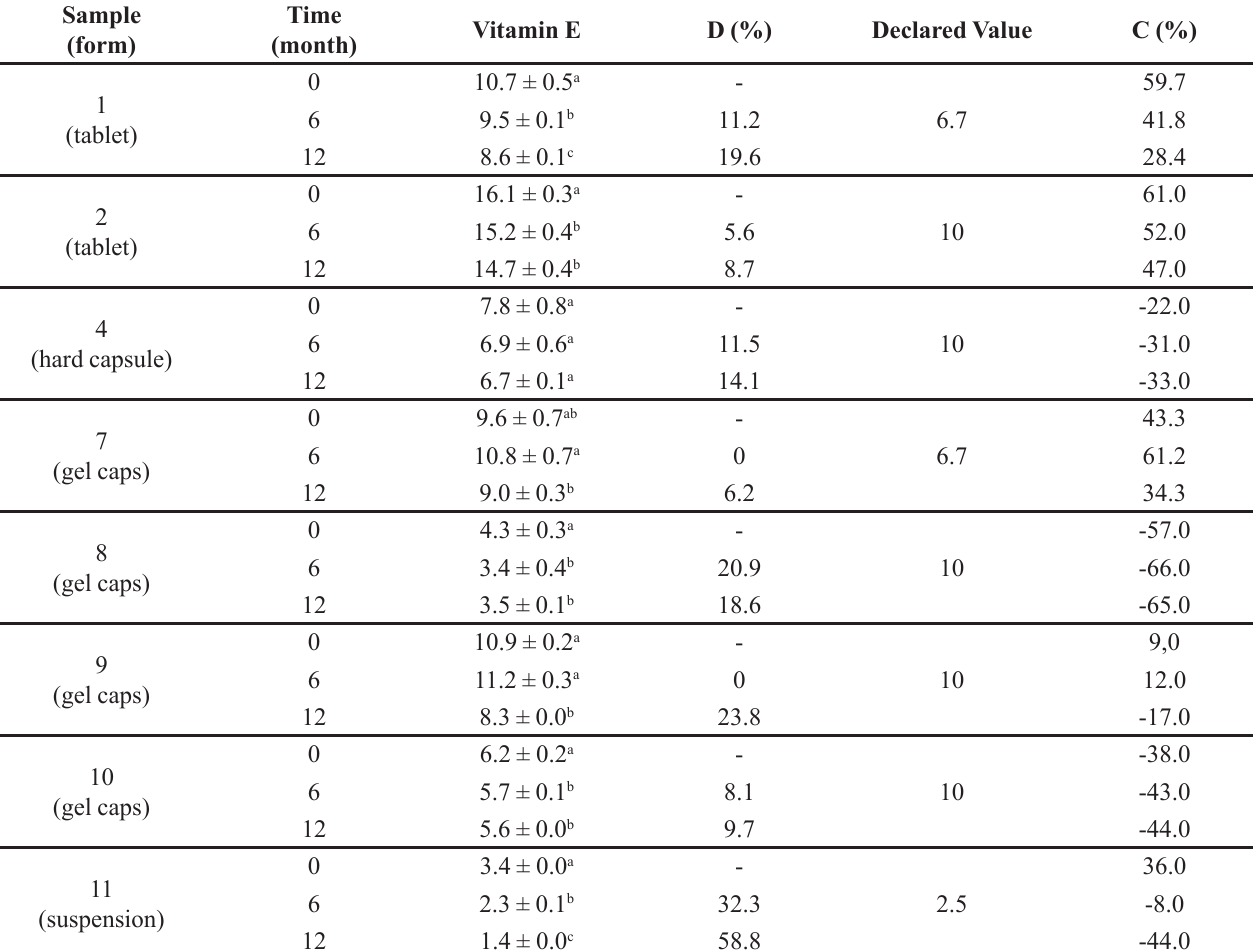
TABLE III - Analysis of vitamin E (mg α-TE/serving) in supplements during storage